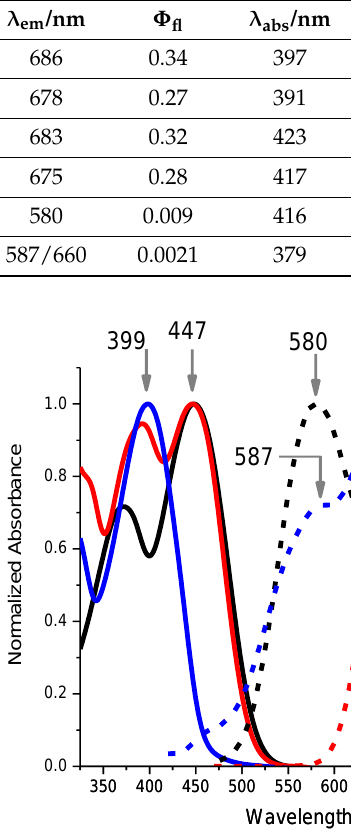
Table 1. Photophysical properties of compounds in different solvents.